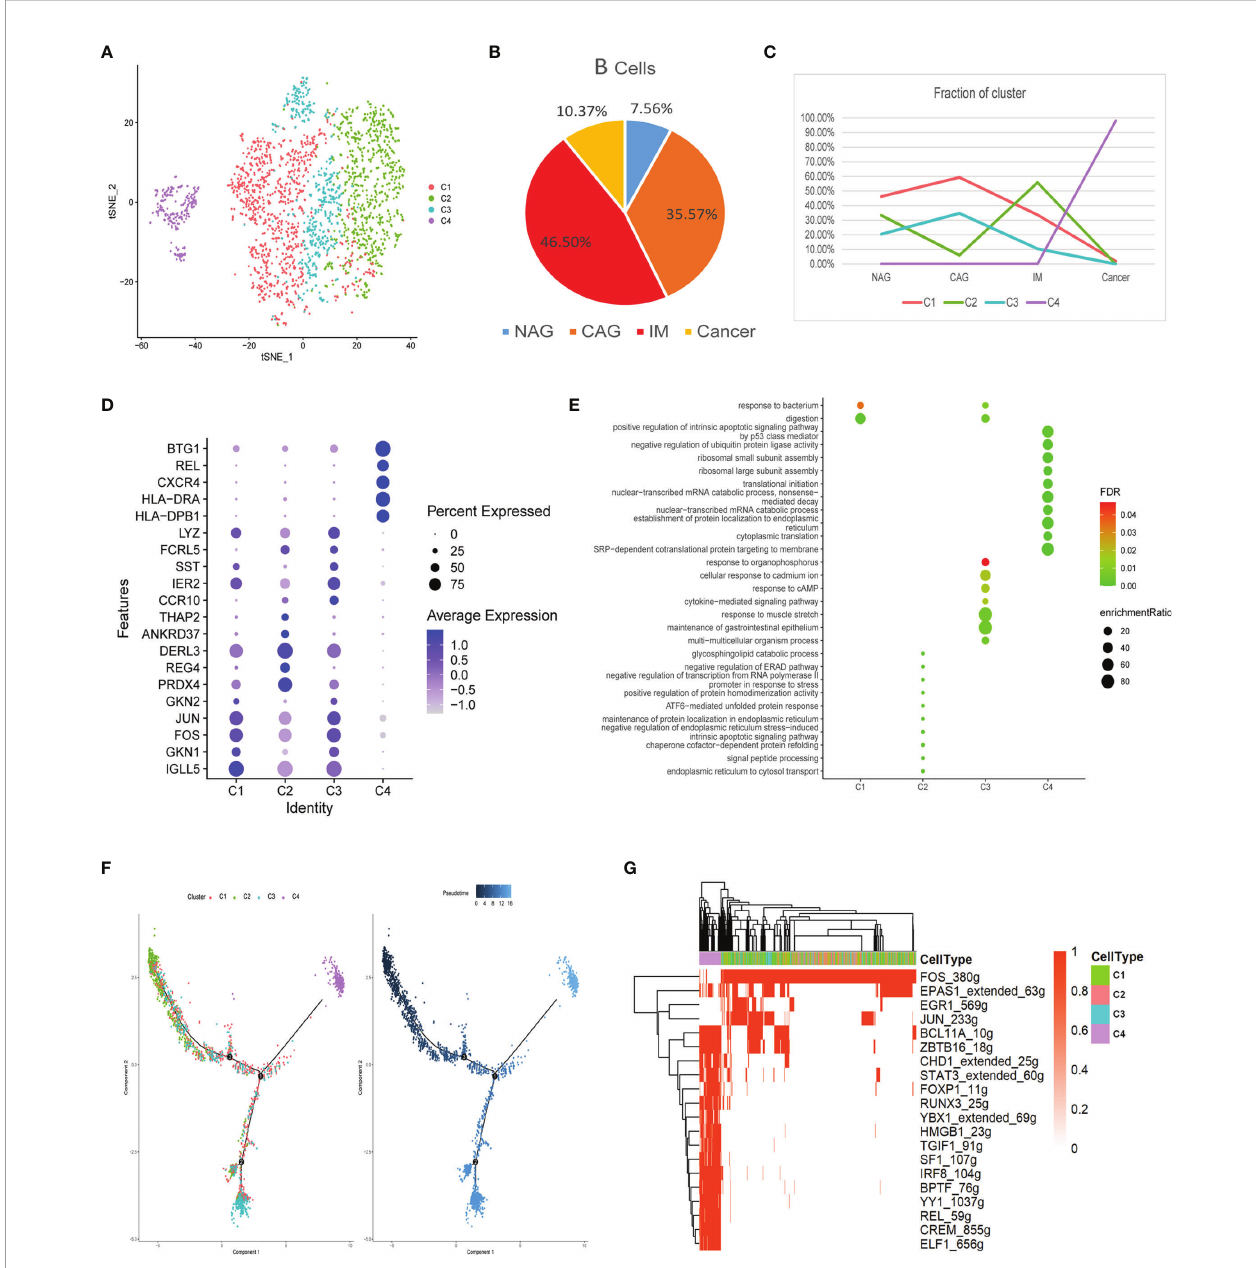
FIGURE 5 | Characterization of multiple changes in B cell subtypes at different stages (A) tSNE plot of four B cell subclusters. (B) Pie chart representing B cells from different pathological stages. (C) Line chart displaying changing trend of the proportion of the four cell types across the four stages. (D) Bubble plot of the top fi ve markers of each cell cluster; dot sizes represent abundance while colors represent expression levels. (E) Bubble plot showing the biological functions of different cell clusters using GO; dot sizes represent abundance while colors represent q values. (F) B cell differentiation trajectory in the four stages, with each color coded for pseudotime (right) and clusters (left). (G) AUC scores of transcription factor expression regulation using SCENIC. Results converted to binary data were visualized as heatmap plots constructed using the pheatmap function of